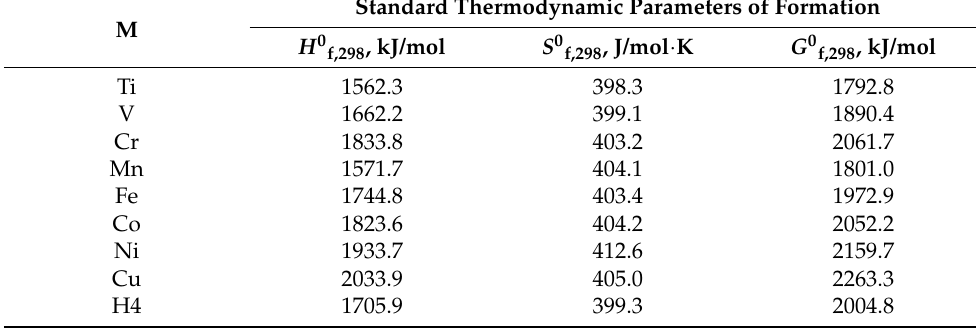
Table 4. Standard thermodynamic parameters of formation ( H 0 f ,298 , S 0 f ,298 and G 0 f ,298 ) for various M(N 12 ) calculated by DFT M06/TZVP